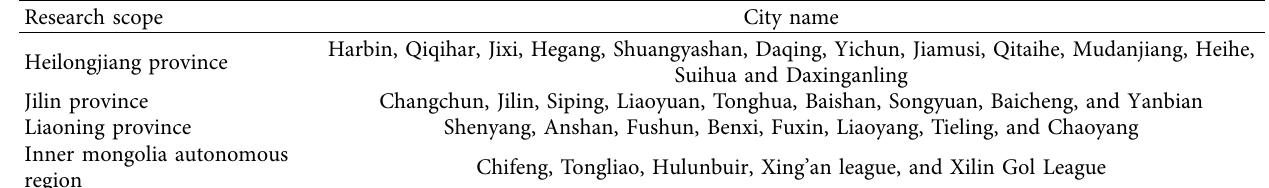
Table 3: Thirty-five cities in Northeast